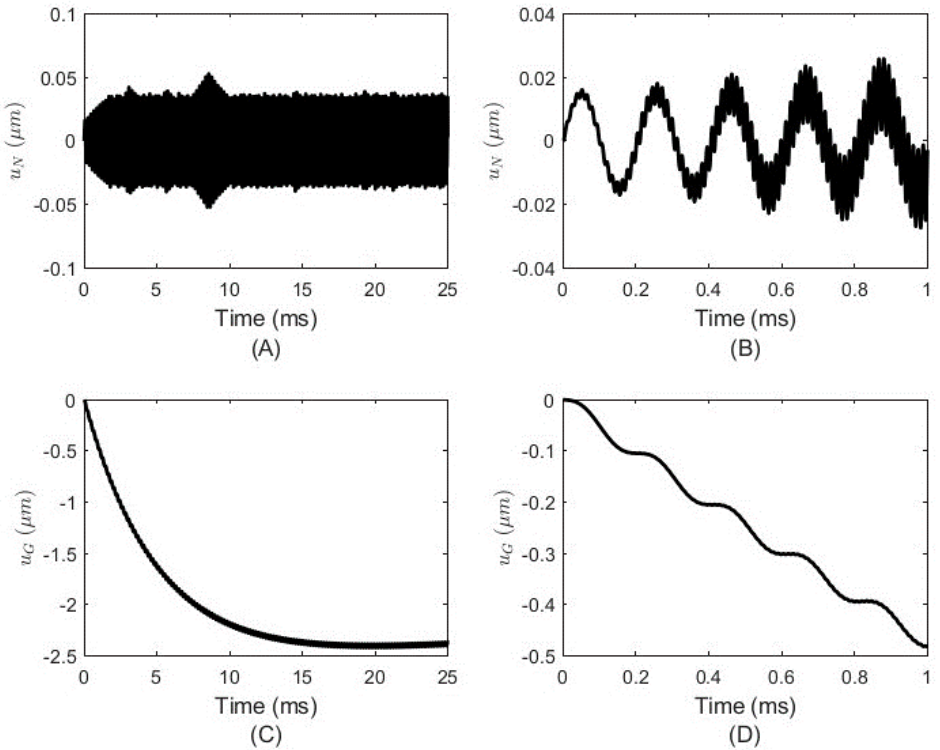
Figure 9. Results for the brain-on-a-chip with two glia’s endfeet in the case of non-decaying synthesis of NO: (A) neuronal displacement 𝒖 𝑵 , (B) a zoom-in of 𝒖 𝑵 , (C) displacement of the endfoot 𝒖 𝑮 , (D) a zoom-in of 𝒖 𝑮